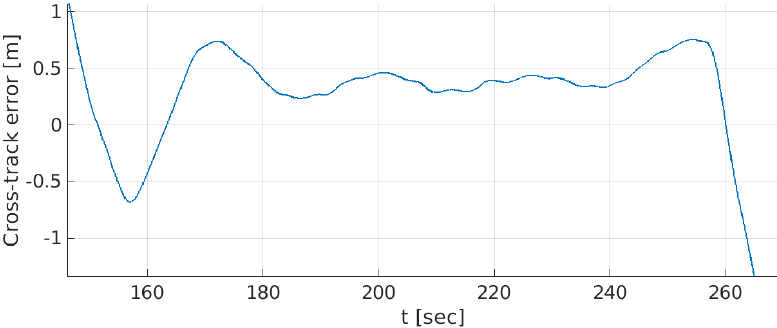
Figure 24. Cross-track error, employing the SPARUS II configuration along a single transect.